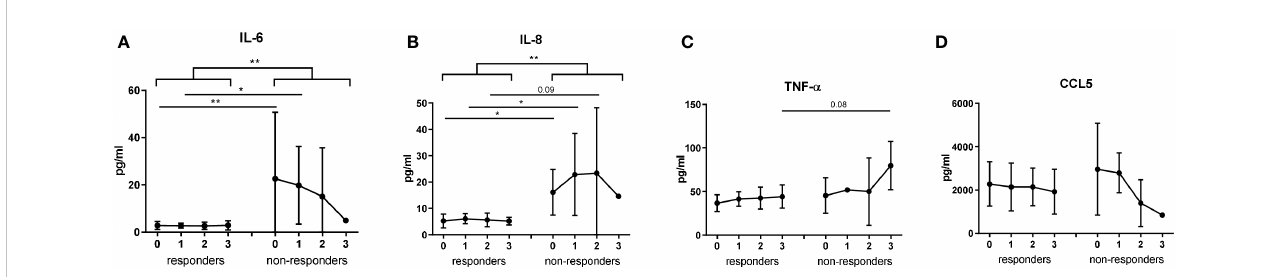
FIGURE 6 Evaluation of cytokine and chemokine concentrations in melanoma patients during the ICI treatment. Levels of IL-6 (A) , IL-8 (B) , TNF- a (C) and CCL5 (D) were measured in plasma of metastatic patients responding (n=12) and non-responding (n=4) to the ICI therapy (point 0 - before the treatment; 1 - after the fi rst injection; 2 - after the second injection; 3 - after the third injection) by bio-plex assay and expressed as pg/ml. * P < 0.05, ** P <